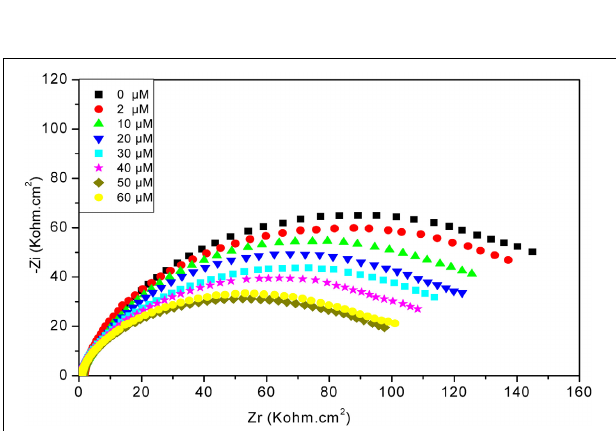
FIGURE 5 | Nyquist diagrams for different layers of developed biosensor with CRL. Measurements were carried out in PBS 20mM, pH 5.2 with a frequency range of 100mHz–100kHz.